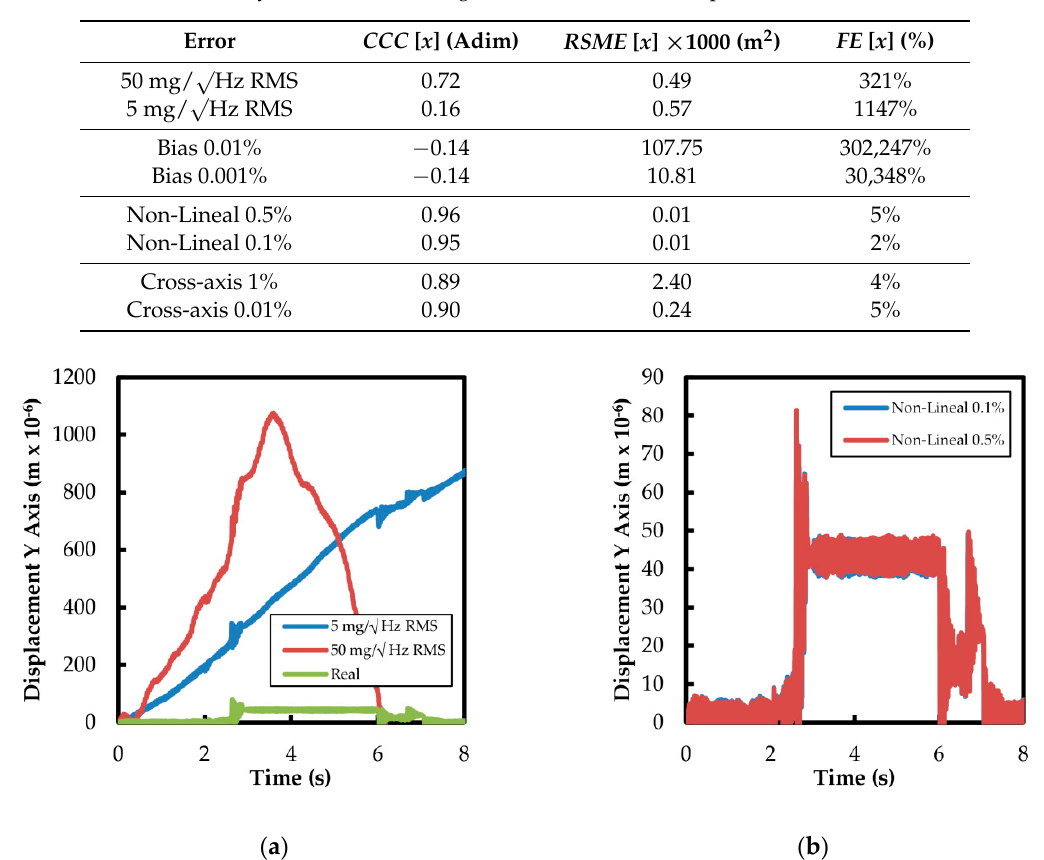
Table 3. Quality indicators in the signal reconstruction of displacement [ x ] in Y axis.